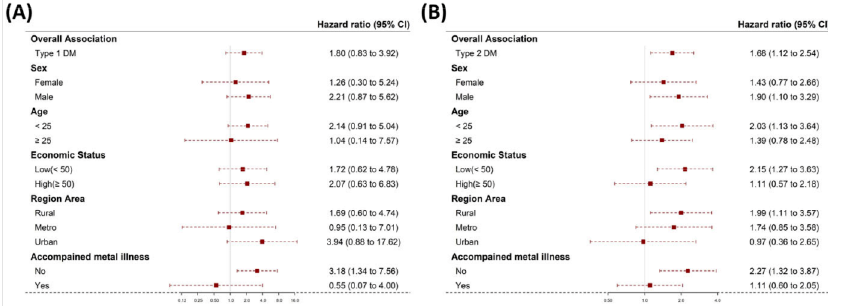
Figure 3. Hazard ratios and 95% confidence intervals of mortality according to the selected participant characteristics by (sex, age, economic status and accompanied mental illness) in non-diabetes ( A ) and diabetes (type 1 or 2) ( B ). Abbreviations: DM, diabetes mellitus. The red boxes indicate the hazard ratio and the horizontal lines extend from the lower limit to the upper limit of the 95 percent confidence interval.